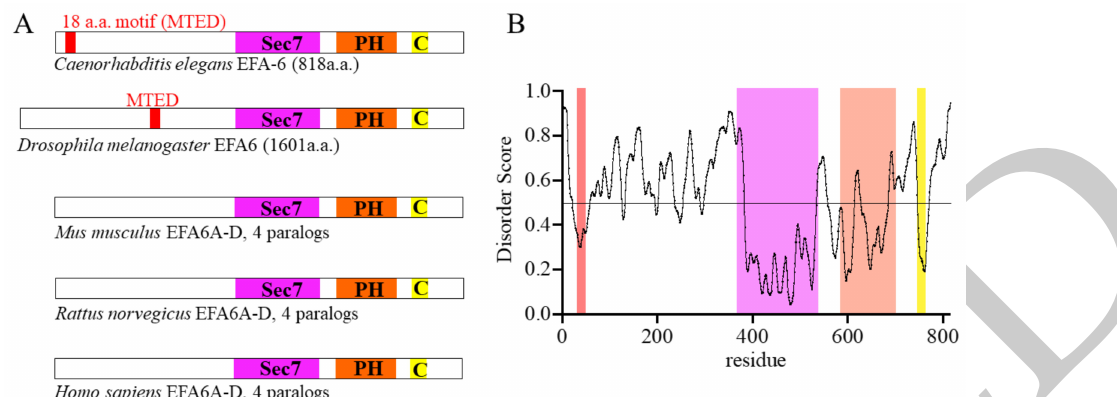
Figure 1. The conserved EFA6 protein family. ( A ) Graphic illustration of EFA6 family proteins showing the PH (Pleckstrin Homology), Sec7 (GEF activity) and CC (coiled coil) domains, based on sequences from NCBI. Not to scale. An 18 a.a. motif (microtubule elimination domain, MTED) is present in C. elegans and Drosophila EFA6 proteins, but absent in mammalian EFA6 proteins. There are four EFA6 paralogs in mammals (EFA6A-D) and the length of their N-termini varies. ( B ) Plot of intrinsic protein disorder probability for C. elegans EFA-6 using PrDos (http://prdos.hgc.jp/cgi-bin/top.cgi), access date 23 May 2021. The N-terminus is overall highly disordered except for the 18 a.a. motif. The domains are highlighted using the same color code as ( A